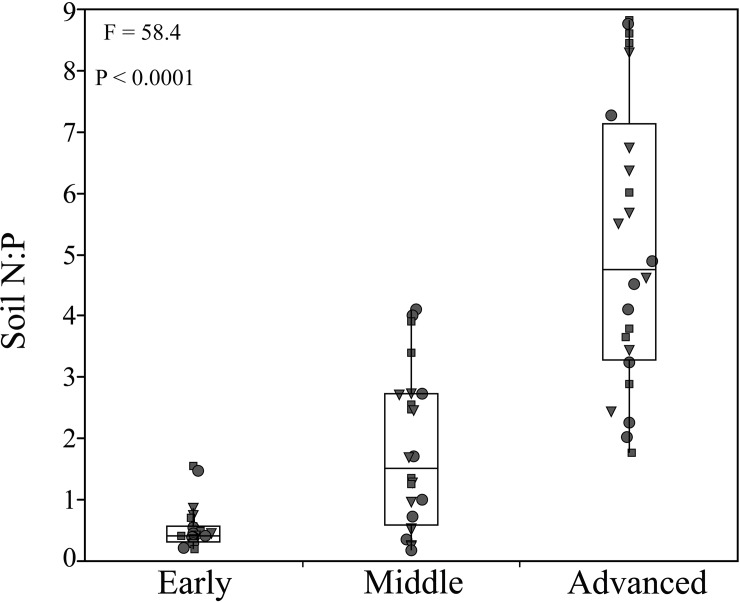
Variation in soil N:P ratios across increasingly older stages of the four primary successions.(Triangle = Grasses; Dots = Legumes; Squares = Forbs).